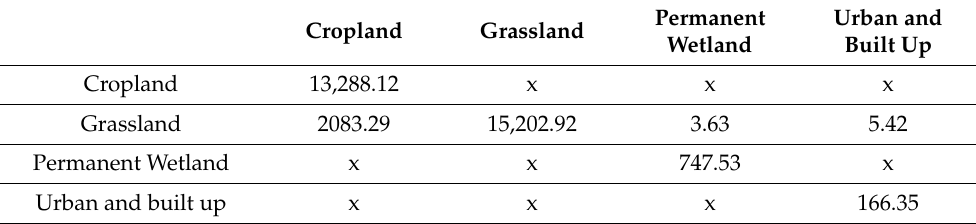
Table 4. Land use transition over the study period (2009–2018) in km 2